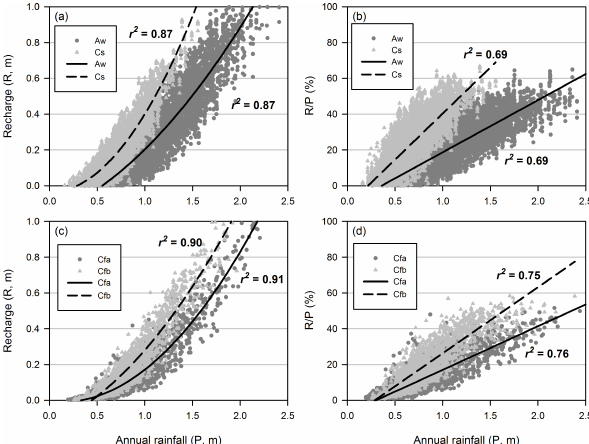
Fig. 9. Relationship between annual recharge ( R ) and rainfall ( P ) ( a , c ) and between R/P and annual rainfall ( b , d ) for perennial veg- etation and soil with K ∼ 1md − 1 ; (a) and (b) summer-dominated rainfall (Aw – tropical savannah) and winter-dominated rainfall (Cs – temperate climate with dry summer); (c) and (d) temperate cli- mate without dry summer (Cfa – hot summer; Cfb – warm